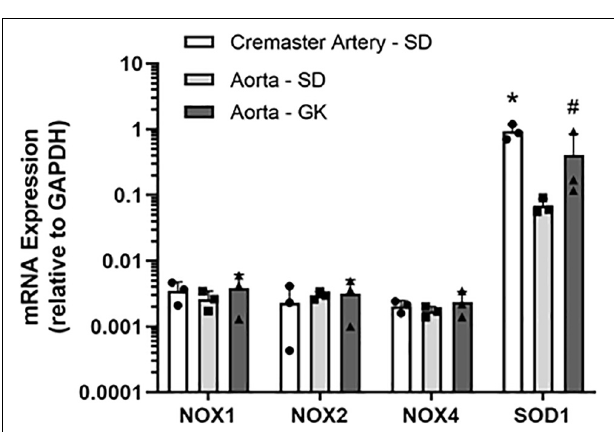
FIGURE 7 | sodium nitroprusside (SNP, 10 µ M) to verify the effectiveness of each treatment. The horizontal lines above and below the tracing indicate the presence of the indicated stimulus or treatment. The histogram in panel (D) quantifies ACh and SNP evoked vasodilation in the absence and presence of each treatment. The plot in panel (E) quantifies the peak inhibition of myogenic tone at each concentration of 2-APT under each of the treatment conditions described above. The solid line fits to the data points were calculated using a Hill equation (see section “Materials and Methods”). The plot in panel (F) describes the ratio of the evoked 2-APT response remaining after 8 min treatment vs. the peak inhibitory response observed at ∼ 1 min for each 2-APT concentration in the presence of the noted treatment conditions. A ratio of 1 would indicate no decay in the magnitude of response over time. Ratios for the magnitude of 2-APT evoked dilation observed at the end vs. the beginning of the 8 min treatment period under control conditions were calculated from tracings equivalent to that presented in Figure 2A . Data are presented as mean ± S.D. ( n = 13 arteries for the control condition, and 3 for each of the described treatment conditions). Statistical analysis was performed using a one-way ANOVA and a Newman–Keuls post hoc test. An asterisk indicates a significant difference from the control value, P < 0.05. The # sign denotes a statistical difference vs. control for 2-APT evoked responses in the presence